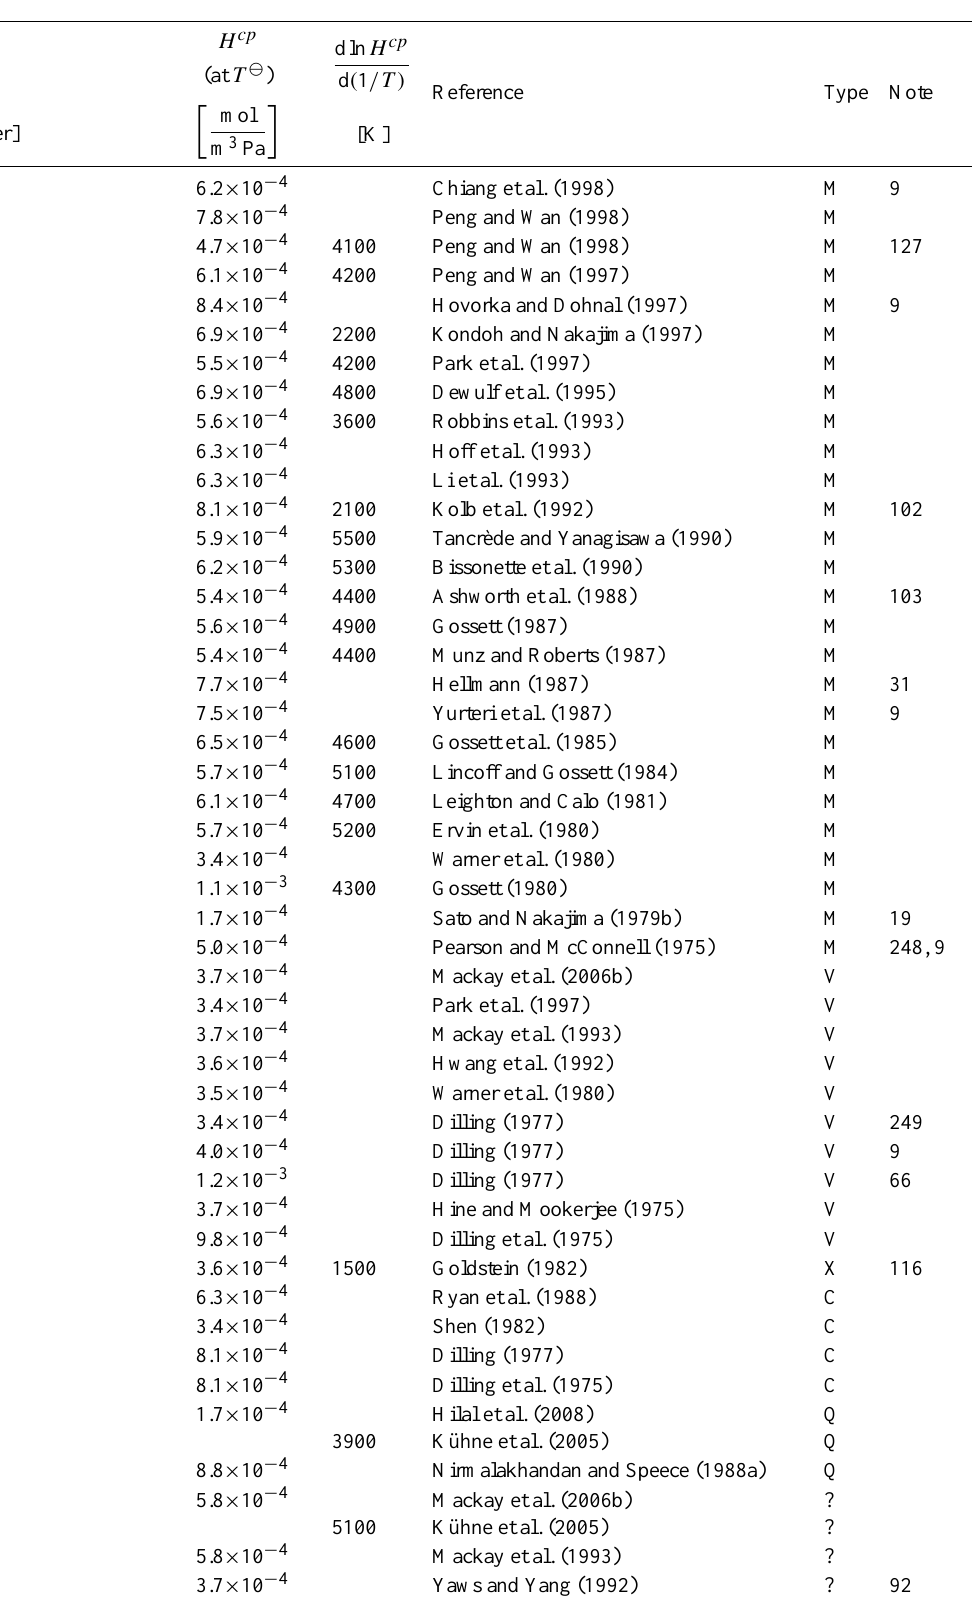
Table 6: Henry’s law constants for water as solvent (...continued) Substance